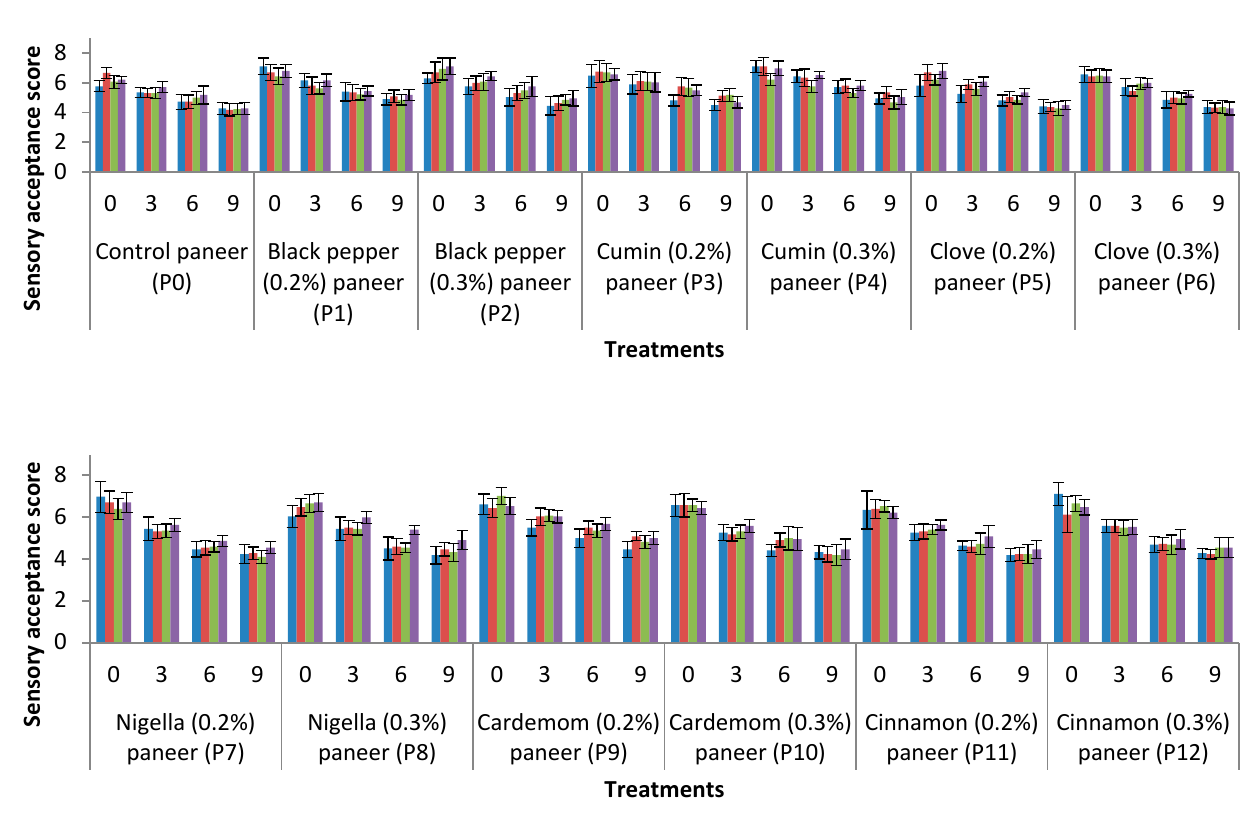
Figure 2. Sensory acceptance scores regarding appearance and color (means ± SD, blue bars), flavor (means ± SD, red bars), texture (means ± SD, green bars), and overall acceptability (means ± SD, purple bars) of spicy paneer during storage at 5 °C.